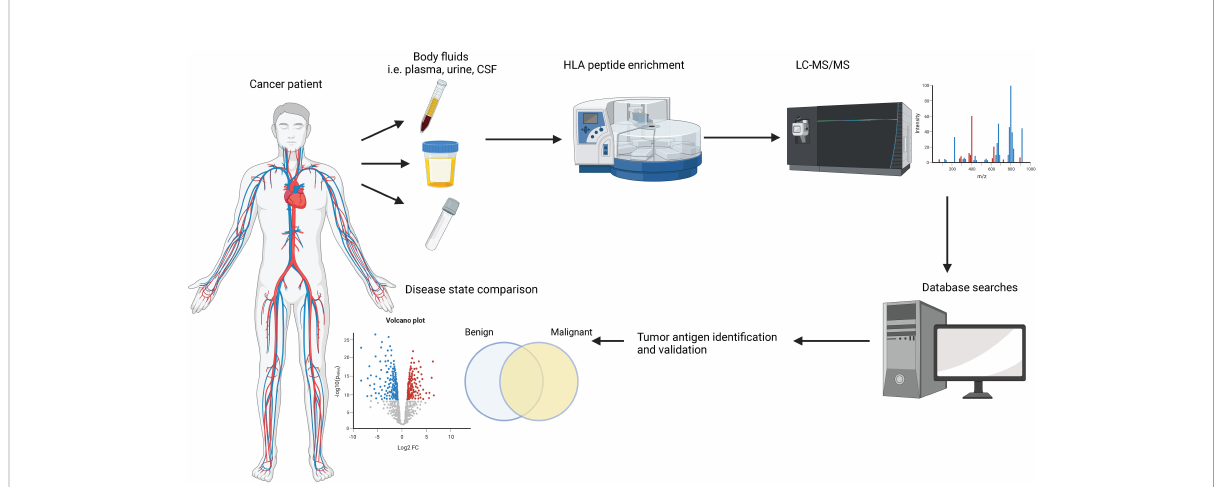
FIGURE 1 Commonly used pipeline to study HLA immunopeptidomes. Body fl uids are extracted from cancer patients or healthy donors via minimally invasive procedures. sHLA-peptide complexes are enriched by immunoprecipitation assays and the peptide cargo is separated under mild acidic conditions. The peptides are analyzed by liquid chromatography-tandem mass spectrometry (LC-MS/MS) and various software packages are used to search the data against a human proteome database to obtain peptide sequence information. State-of-the-art bioinformatic analyses are employed to shortlist potential